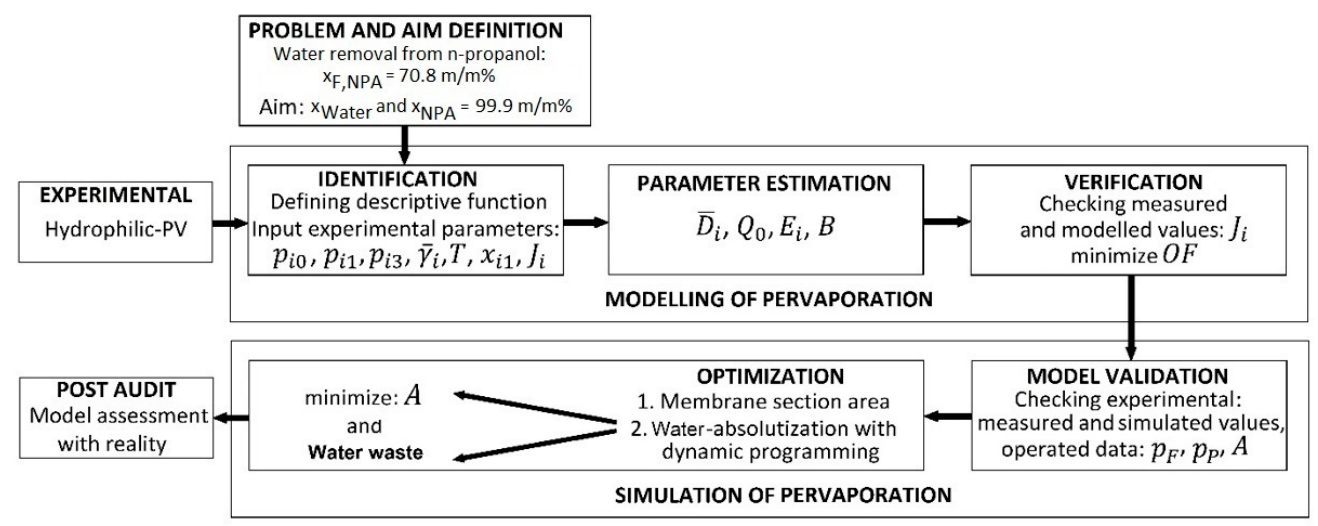
Figure 1. Flowchart of modelling and simulation of hydrophilic pervaporation in the case of n-propanol dehydration (based on the flowchart of Haaz and Toth [6] ).